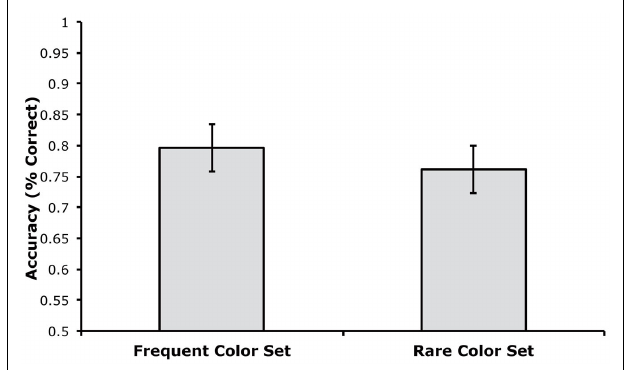
FIGURE 4 | Mean change detection accuracy for trials with the frequent and rare color sets in Experiment 2 (error bars show 95% within-subjects confidence intervals, as described by Loftus and Loftus,